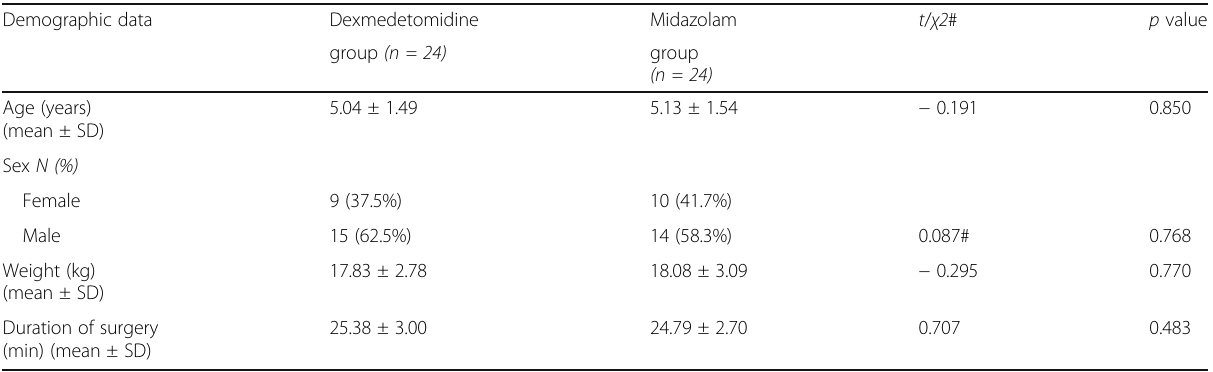
Table 6 Patients ’ demographic